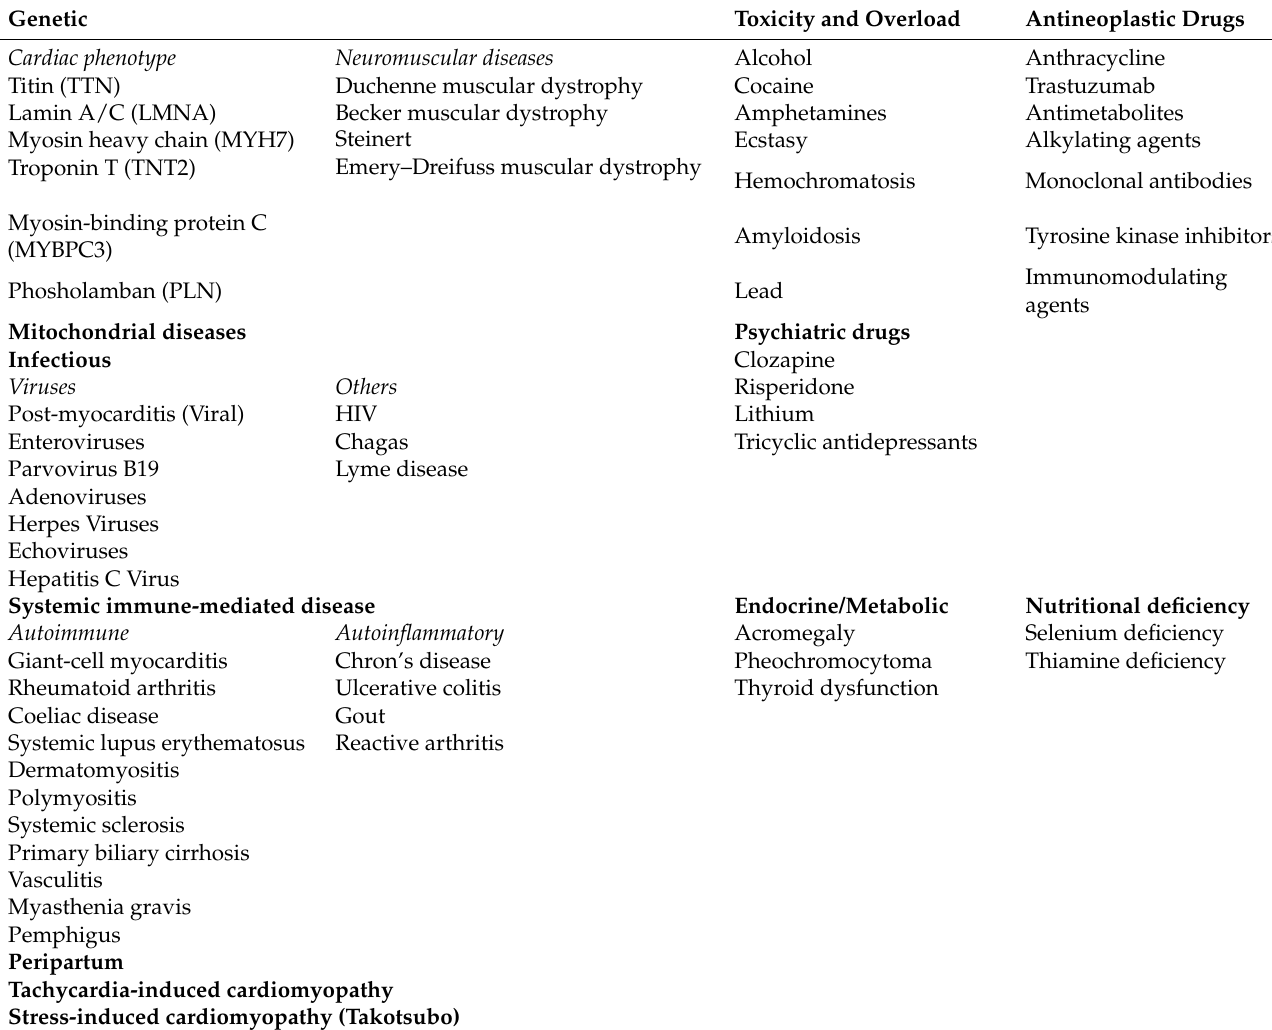
Table 1. Aetiologies of dilated